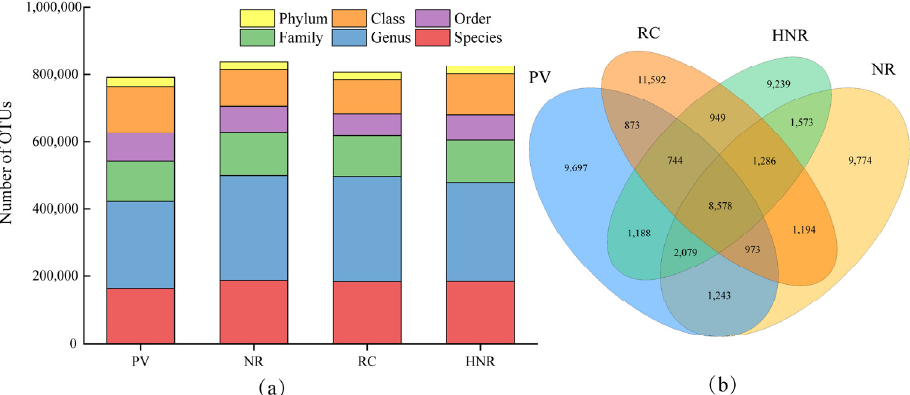
Figure 4. Statistics of microbial operational taxonomic unit (OTU) classification and taxonomic status identification in the study area ( a ); Venn diagram of the number of microbial OTUs ( b ).